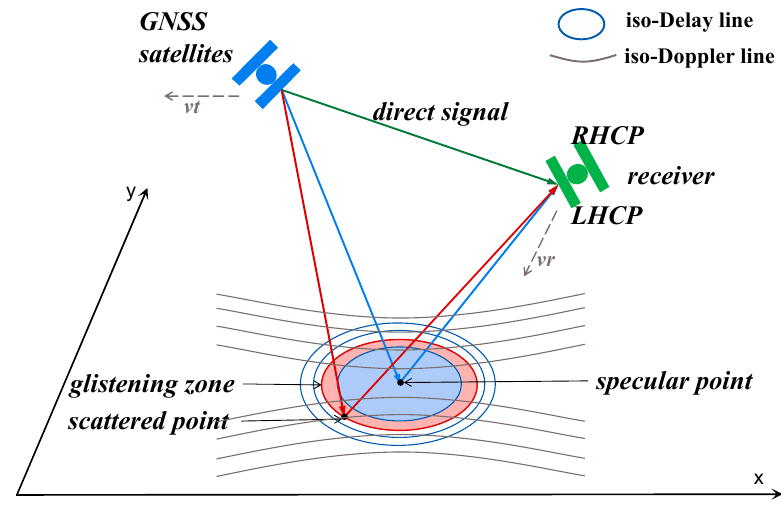
Figure 1. Bistatic radar scattering map.